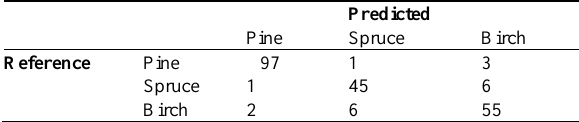
Table 2. Confusion matrix of classification based on intensity features of all returns with 15 best features. Total accuracy is 91.2%.